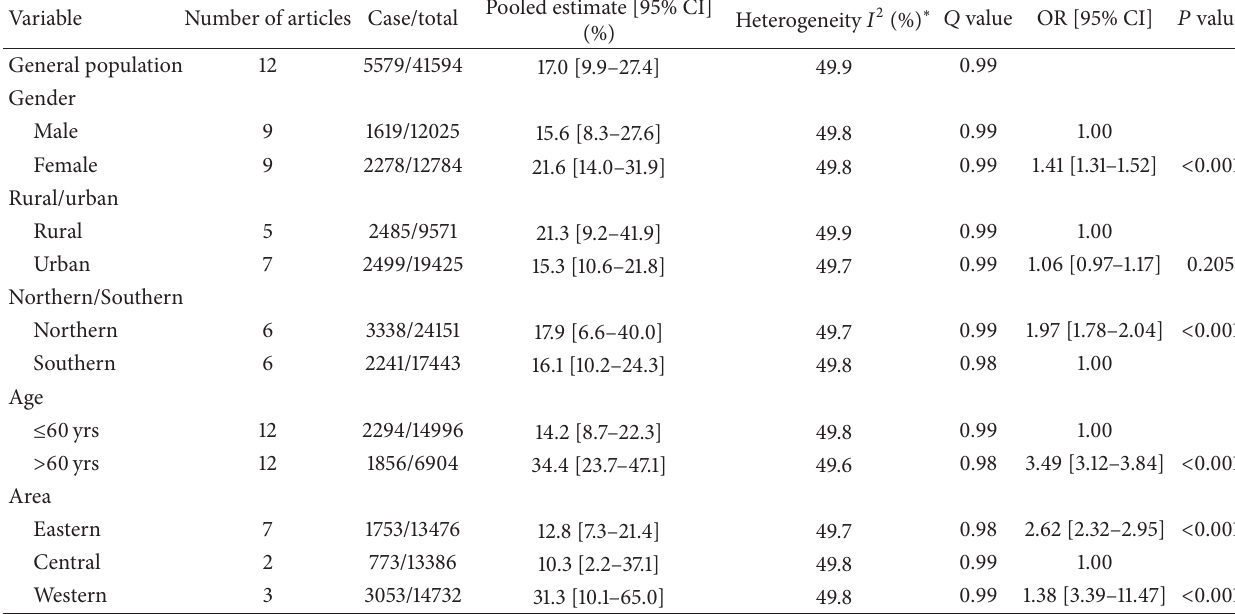
Table 2: The pooled prevalence of DES in mainland China with different populations and regions.